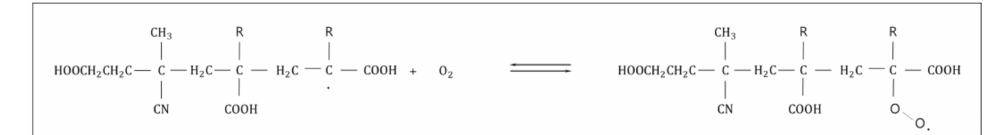
Figure 5. Chemical structure that appears in the presence of oxygen during radical reactions.